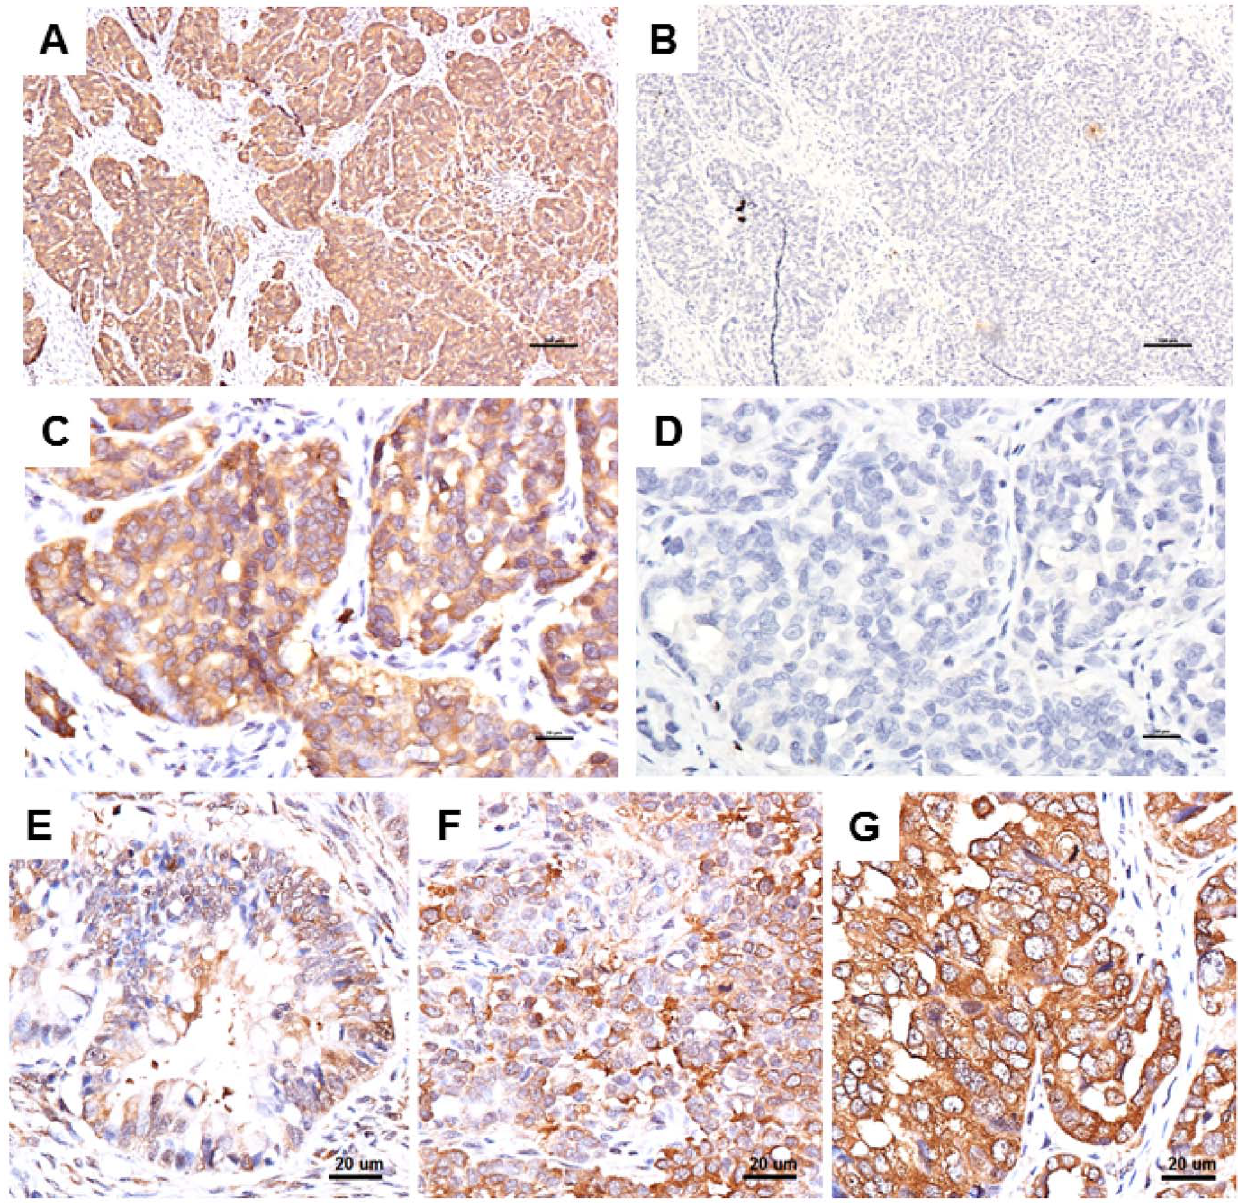
Figure 1. Specificity of the anti-STIP1 antibody (panels A–D) and the intensity of immunostaining for STIP1 (panels E–G). STIP1 expressed in the cytoplasm of ovarian cancer cells is stained brown. The immunoreactivity of STIP1 to the anti-STIP1 antibody in cancer tissues (A, C) was abrogated by the addition of 15 m g of recombinant human STIP1 during incubation (B, D); these results support the specificity of the anti-STIP1 antibody. The intensity of the STIP1 staining was graded as 1 (E), 2 (F), and 3 (G). All of the slides presented here were from ovarian serous carcinomas. The scale bars represent 100 m m (A, B) or 20 m m (C–G).